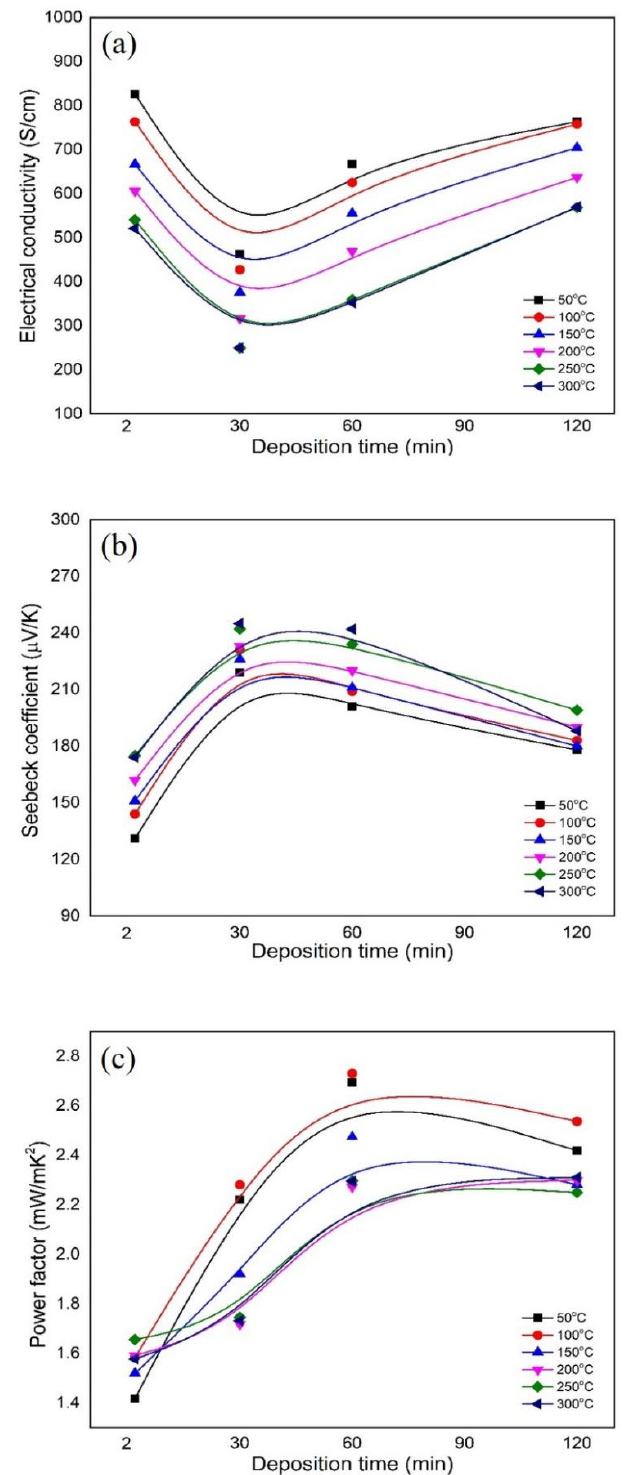
Figure 7. Temperature dependence of the thermoelectric properties as a function of film thickness of the deposited Sb 2 Te 3 films: ( a ) electrical conductivity, ( b ) Seebeck coefficient and ( c ) power factor. A comparison of the thermoelectric properties of the deposited Sb 2 Te 3 thick film with a thickness of a few micrometers using various methods is shown in Table 2. Although